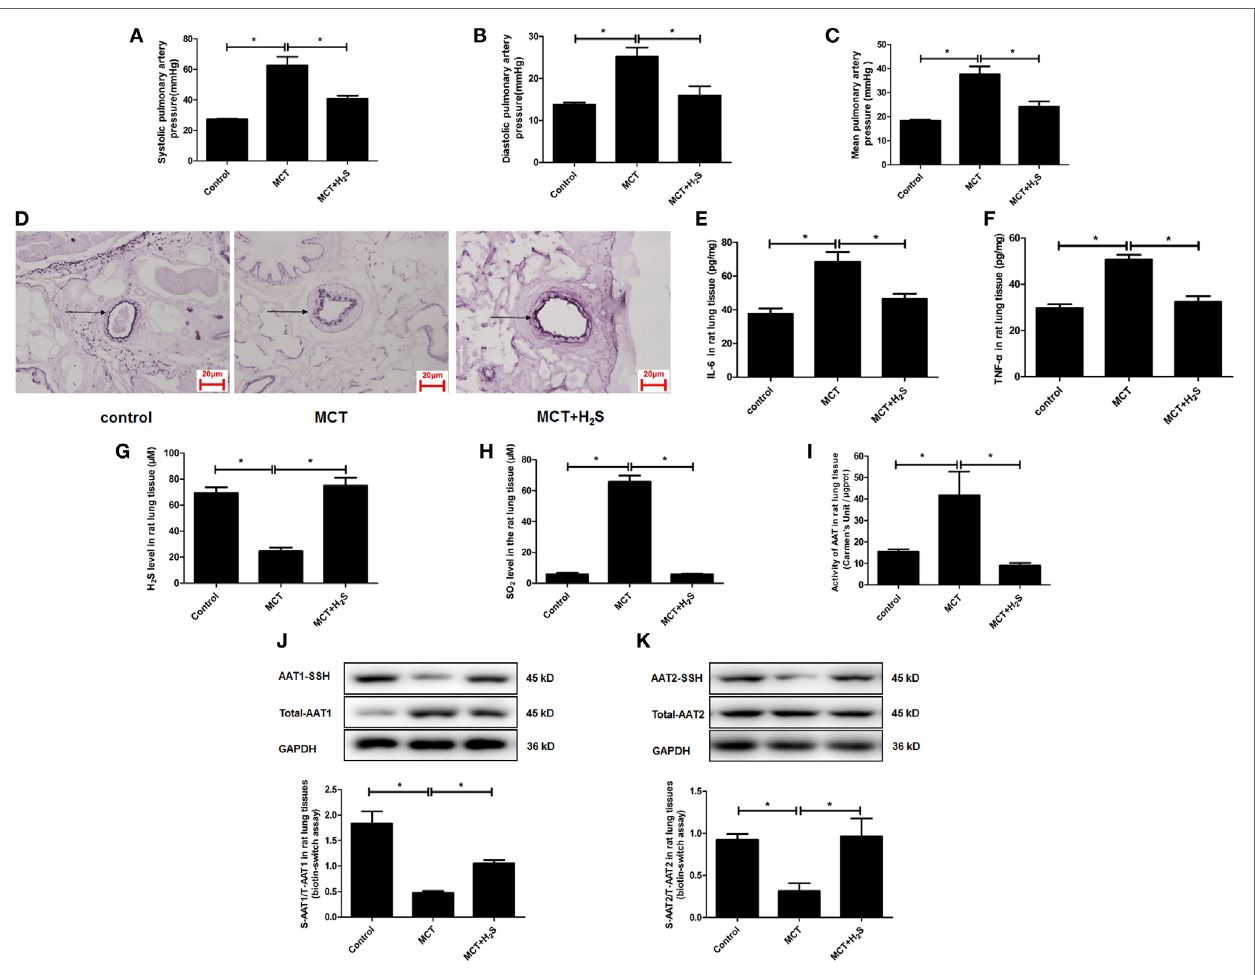
FigUre 8 | The endogenous sulfur dioxide (SO 2 )/aspartate aminotransferase (AAT) pathway was upregulated by the downregulated H 2 S production in the rats with pulmonary vascular inflammation. (a–c) The systolic pulmonary artery pressure, diastolic pulmonary artery pressure and mean pulmonary artery pressure of rats measured by right heart catheterization. (D) The morphological change of small pulmonary arteries in the rats observed following the staining by the modified Weigert’s elastic fiber dye. The small pulmonary artery was indicated by dark arrow. The internal and external elastic lamina were shown as dark-purple color under microscope. (e,F) The level of IL-6 and TNF- α in the rat lung tissue detected by enzyme-linked immunosorbent assay. (g) The H 2 S level in the rat lung tissues detected by a an H 2 S-selective sensor. (h) The SO 2 level in the rat lung tissues detected by HPLC assay. (i) AAT activity in the rat lung tissues detected by colorimetry assay. (J,K) Sulfhydration of AAT1 and AAT2 in the rat lung tissues detected by biotin switch assay. * P < 0.05. Data are expressed as means ± SEM, n =